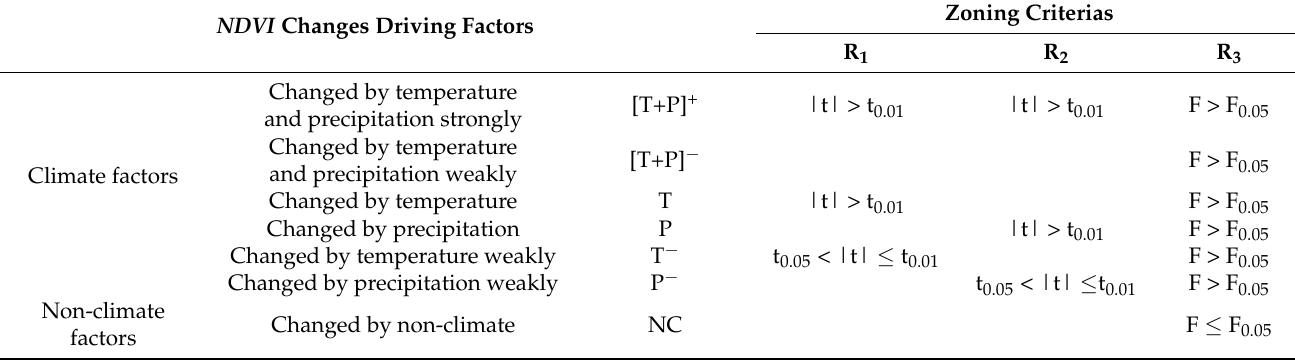
Table 2. Zoning criteria for the impact factors of NDVI changes. R 1 , the t significance test of partial correlation between NDVI and temperature; R 2 , the t significance test of partial correlation between NDVI and precipitation; R 3 , the F significance test of multiple correlations between NDVI and temperature and